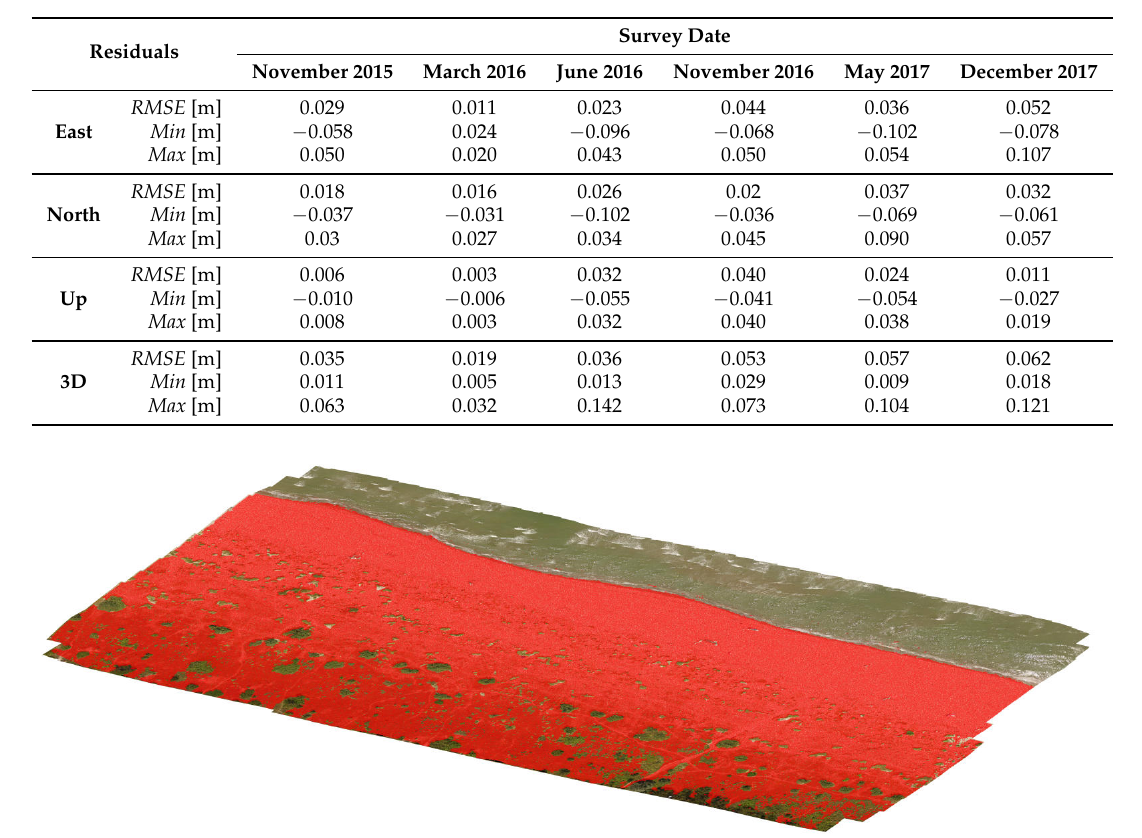
Table 3. Summary of the residuals.